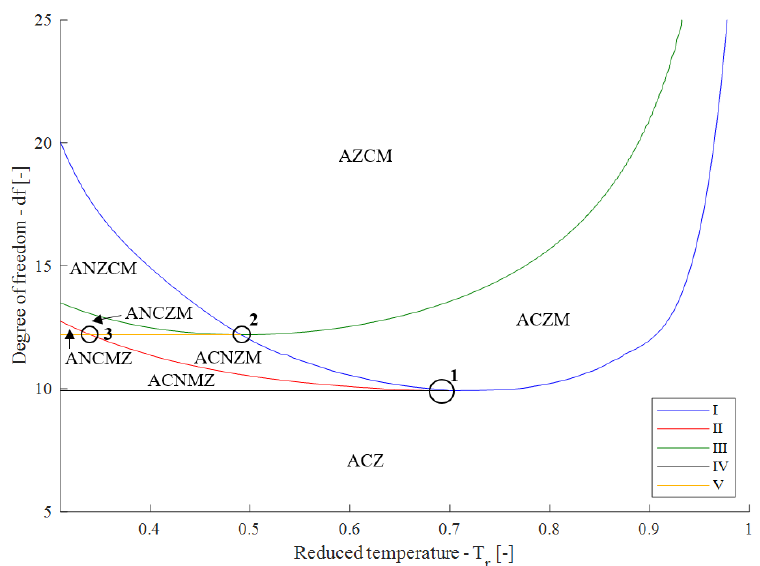
Figure A2. Correlation curves ( df vs . T r ) for the different borders of the maps shown in Figure 4.